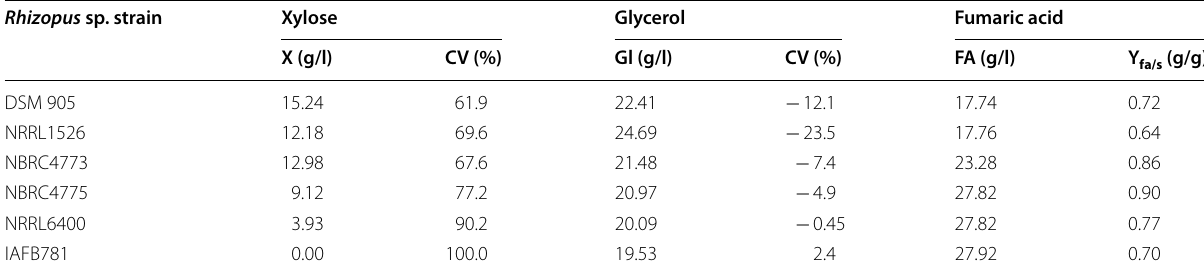
FA (g/l), fumaric acid concentration in medium after culture; X (g/l), xylose concentration in medium after culture; Gl (g/l), glycerol concentration in medium after culture; CV (%), consume value; Y fa/s (g/g), g of fumaric acid produced per g of carbon source consumed